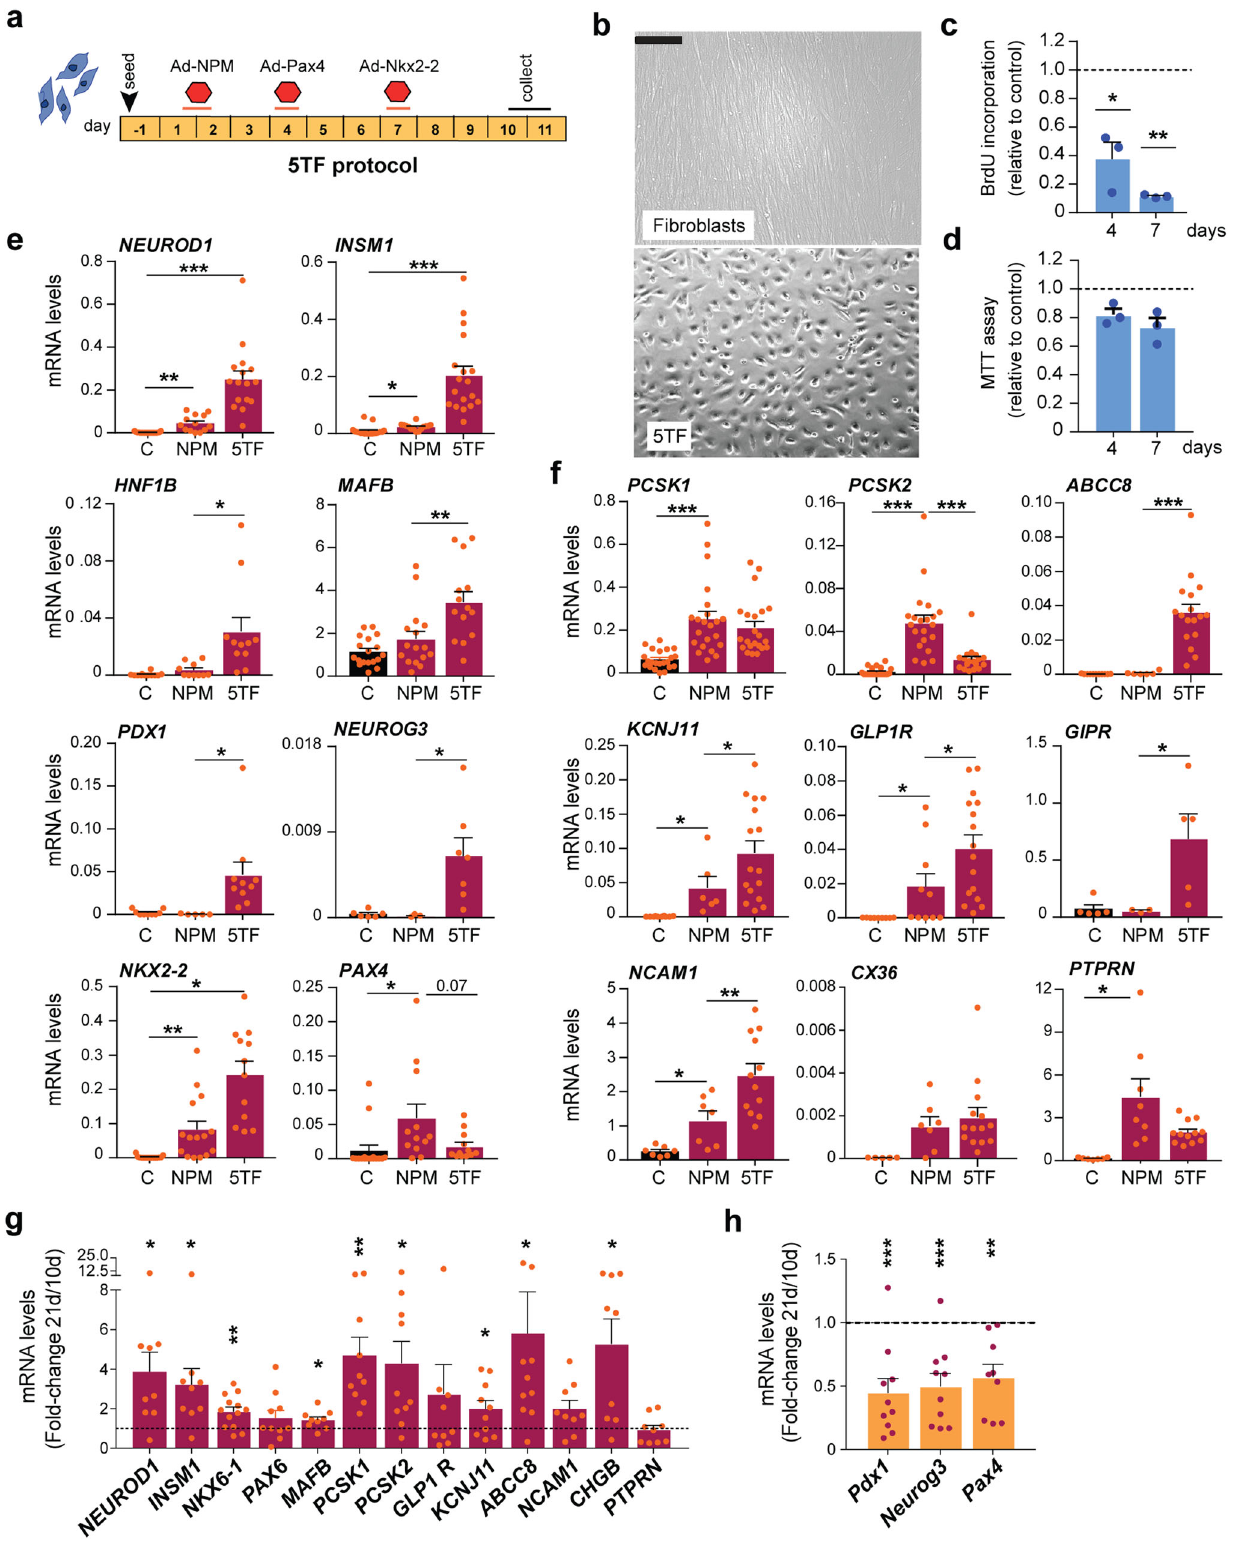
membrane depolarization elicited by high potassium. We found that 65% of the cells exhibited a response to glucose, high potassium, or both, whilst 35% of cells were unresponsive to either stimulus (Fig. 4a and Supplementary Video 1). Parental fi broblasts not engineered for 5TF expression were unresponsive to these stimuli (Fig. 4b and Supplementary Video 2).